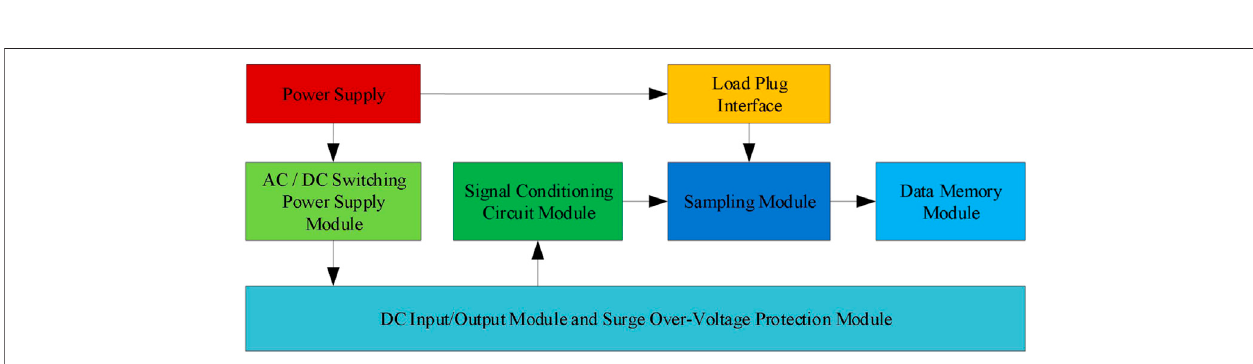
Frontiers in Energy Research |